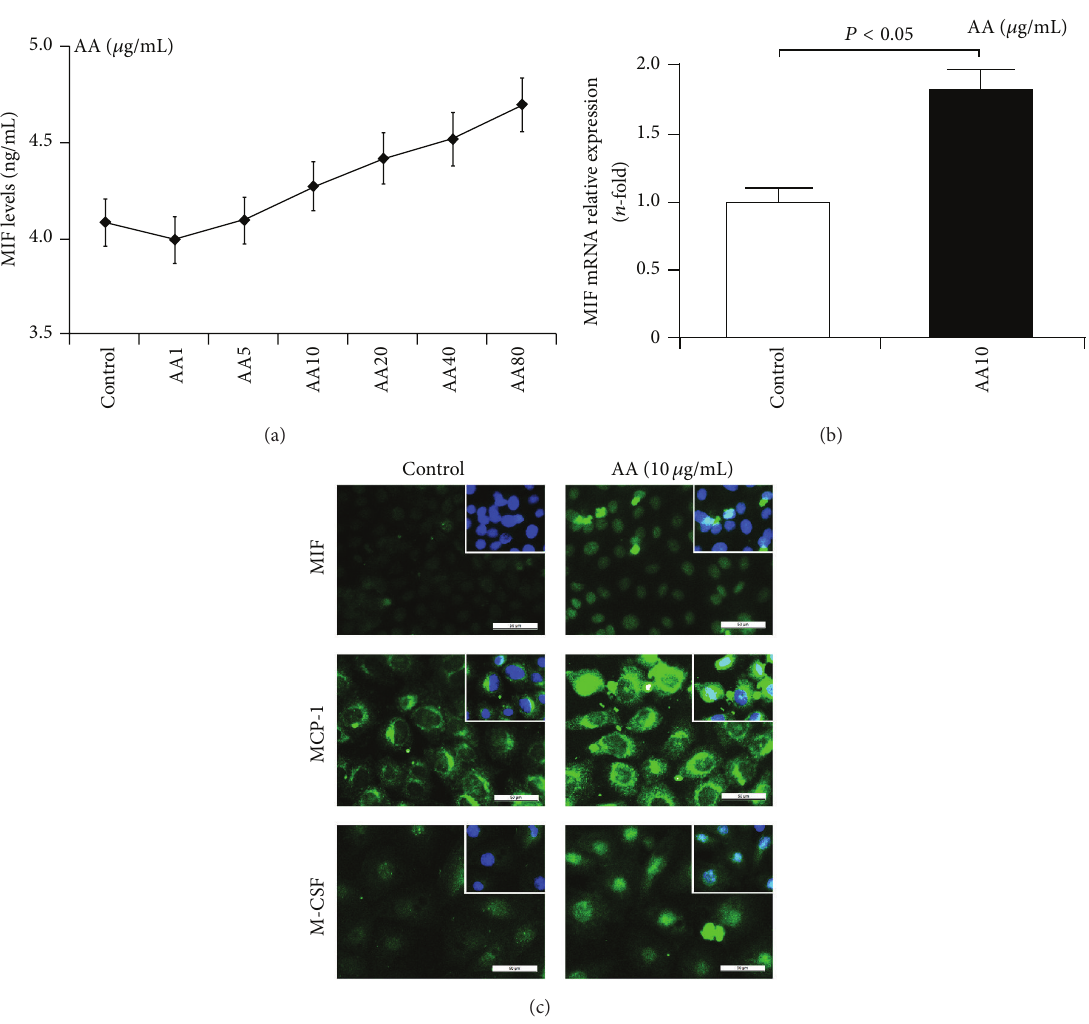
Figure 5: Enhanced MIF expression in TECs after AA injury. (a) ELISA assay revealed AA increased MIF levels in NRK-52E cells in a concentration-dependent manner. (b) qRT-PCR assay showed that MIF mRNA expression was increased in AA-treated NRK-52E cells. (c) Immunofluorescence staining revealed enhanced expression of MIF, M-CSF, and MCP-1 in AA-treated NRK-52E cells. Bar: 50 𝜇